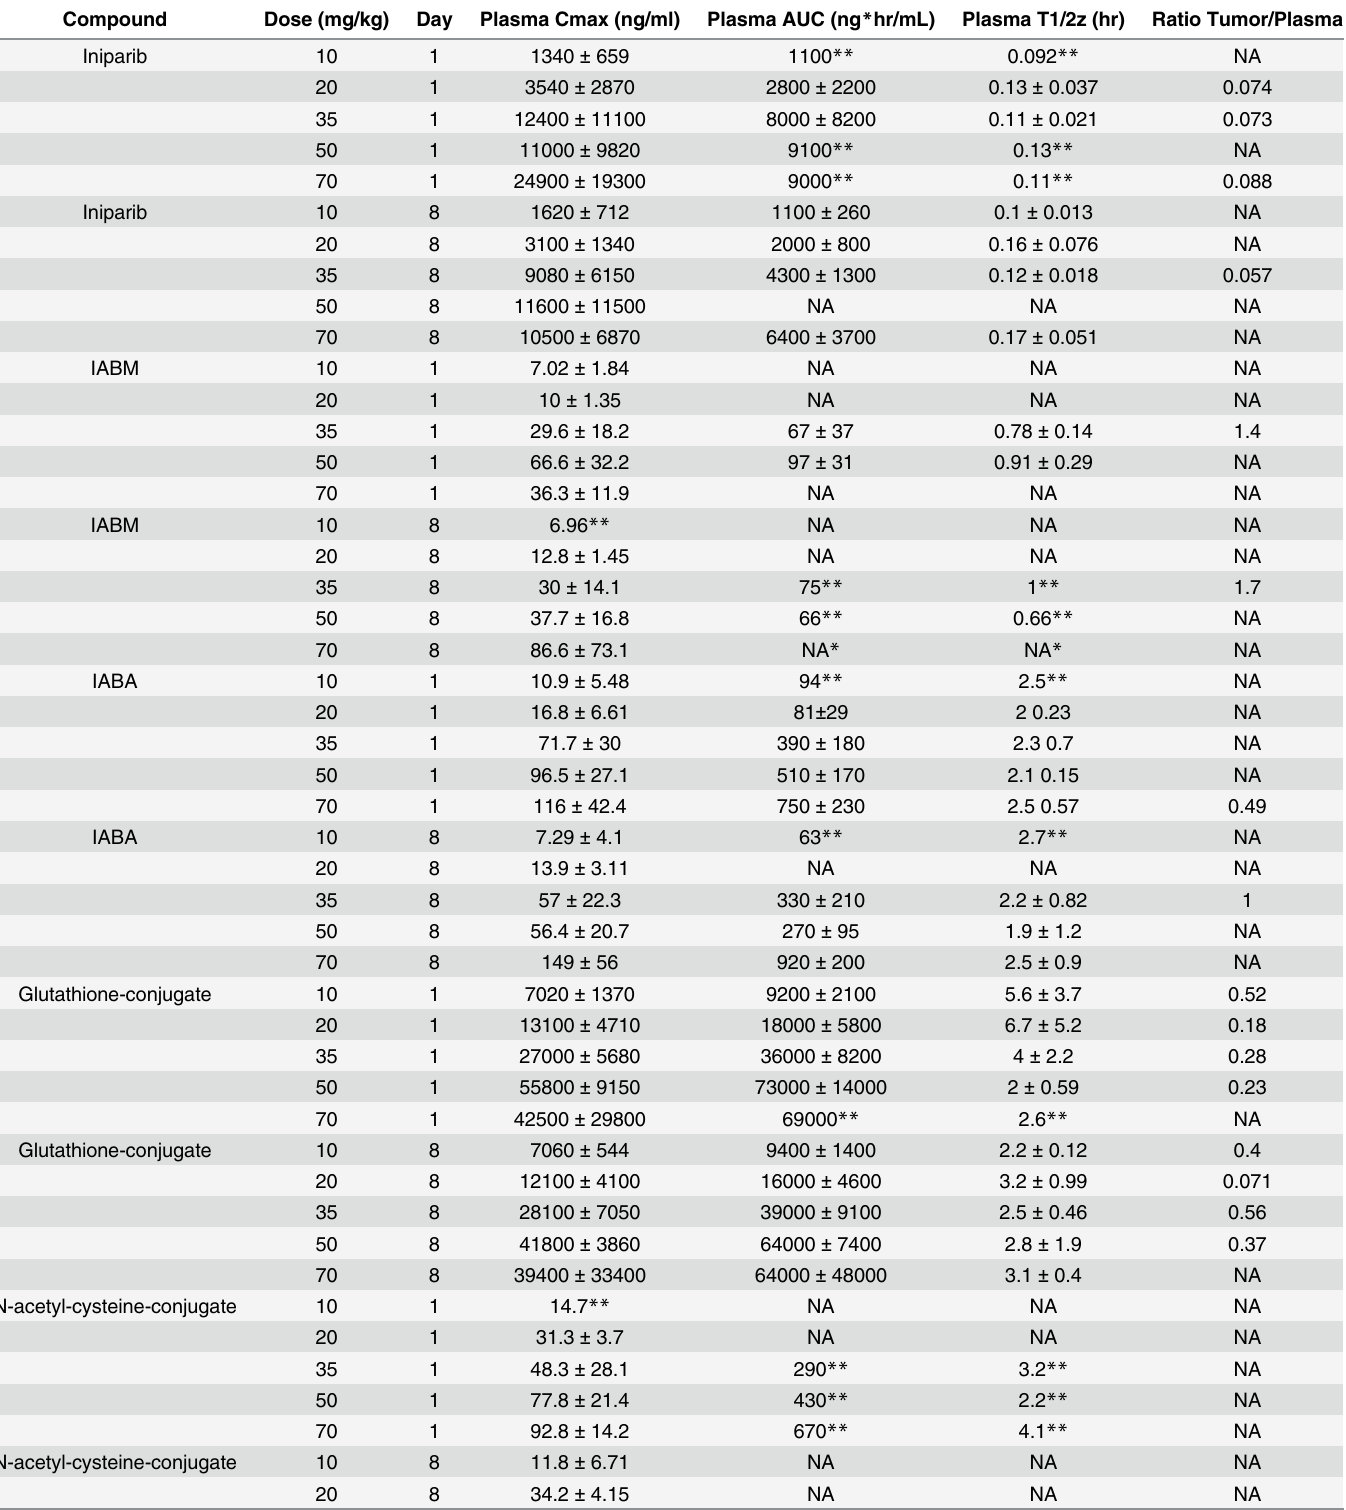
Table 4. Pharmacokinetics and tissue biodistribution of iniparib and selected metabolites in the tumor-bearing dog. Compound Dose (mg/kg) Ratio Tumor/Plasma Iniparib